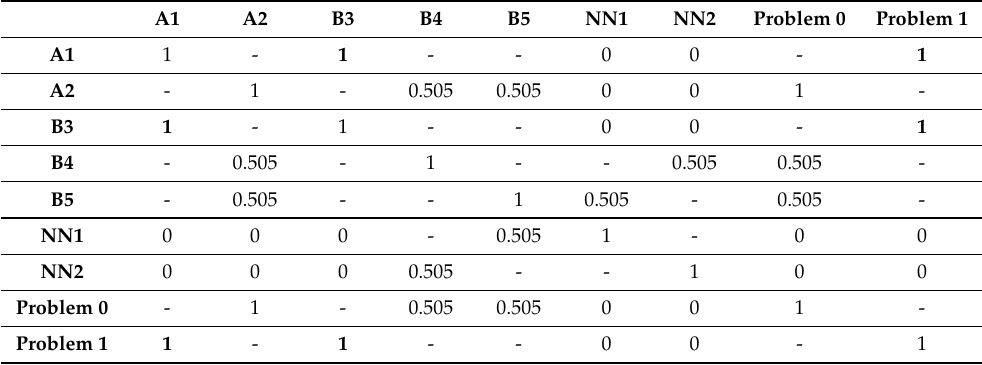
Table 3. Matrix with the PMI values of the interactions between tuples in the example from Tables 1 and